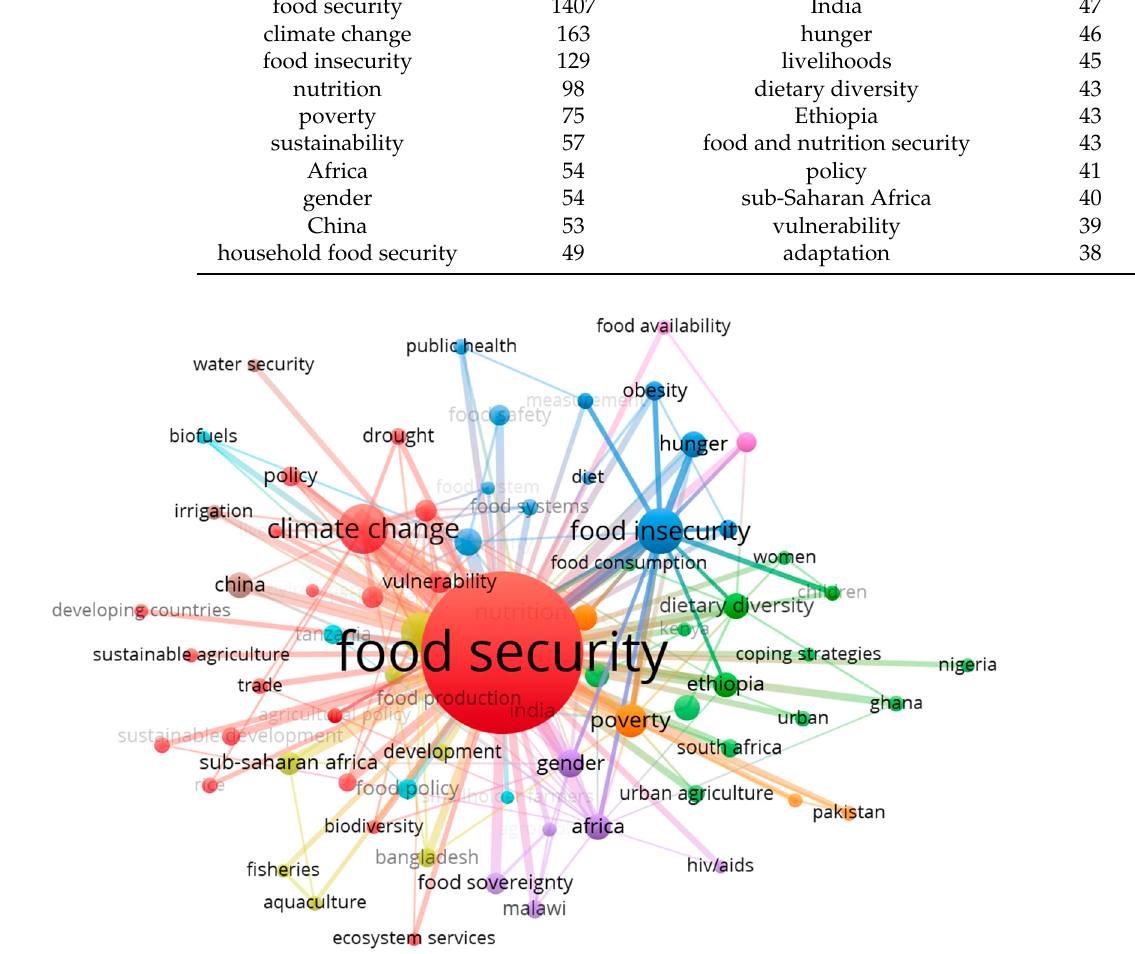
Figure 9. Co-occurrence network for food security keywords.